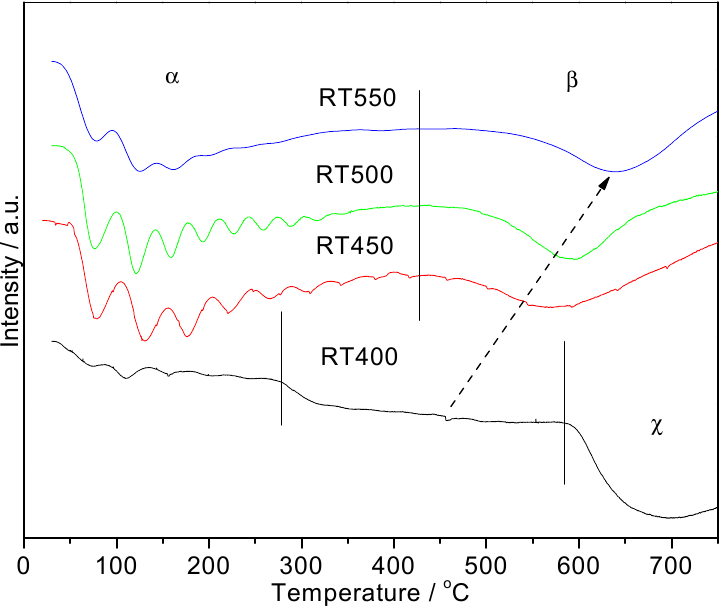
= 400, 450, 500, and